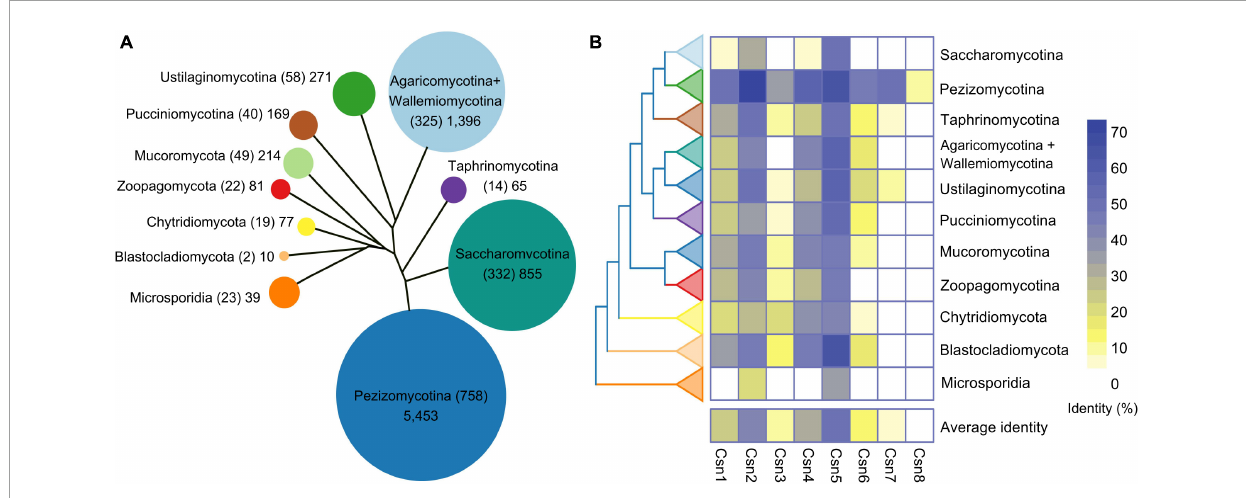
FIGURE1 Genome-wide identification and conservation analysis of the COP9 signalosome (Csn) complex in fungi. (A) Number of Csn subunits at the subphylum or phylum level. The evolutionary tree shows the relationships among the various fungal groups. The area of a circle is proportional to the total amount of the Csn subunits identified in each group. The number of species is indicated in parentheses. (B) Conservation of the Csn subunits in fungi. The eight Csn subunits in Aspergillus nidulans were used as query sequences for